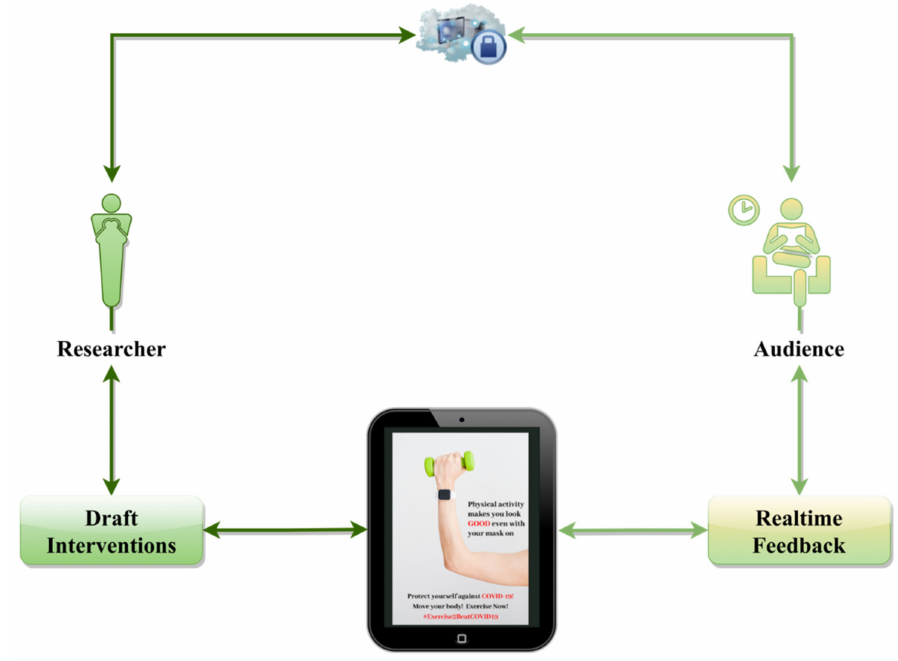
Figure 3. A schematic representation of the proposed co-design